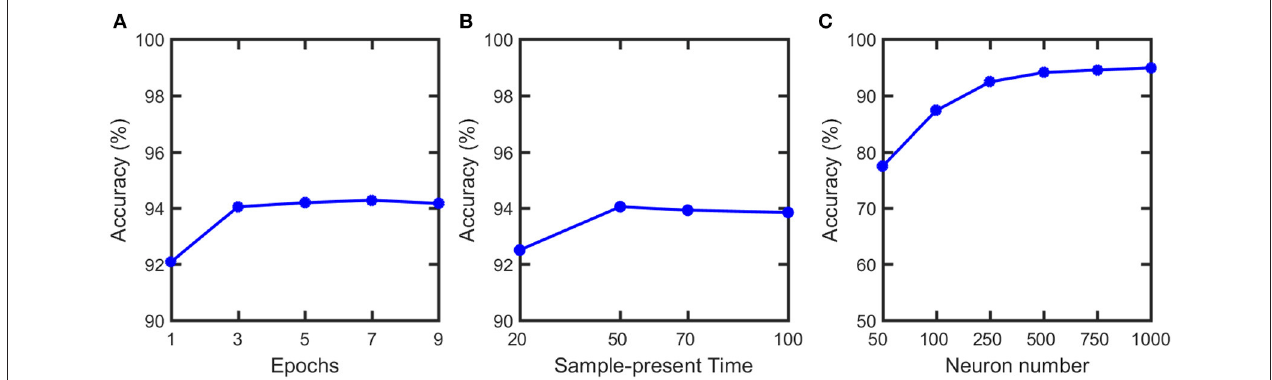
FIGURE 8 | Classification accuracy vs. (A) number of training epochs, (B) sample-present time and (C) output neuron numbers. Classification accuracy does not have noticeable increase after 3 epochs and 50ms present time. Therefore, 3 epochs and 50ms are used in the training. Although the accuracy can be further improved if neuron number increases, it will significantly increase the simulation time. Therefore, we choose to use 500 output neurons in our simulation.